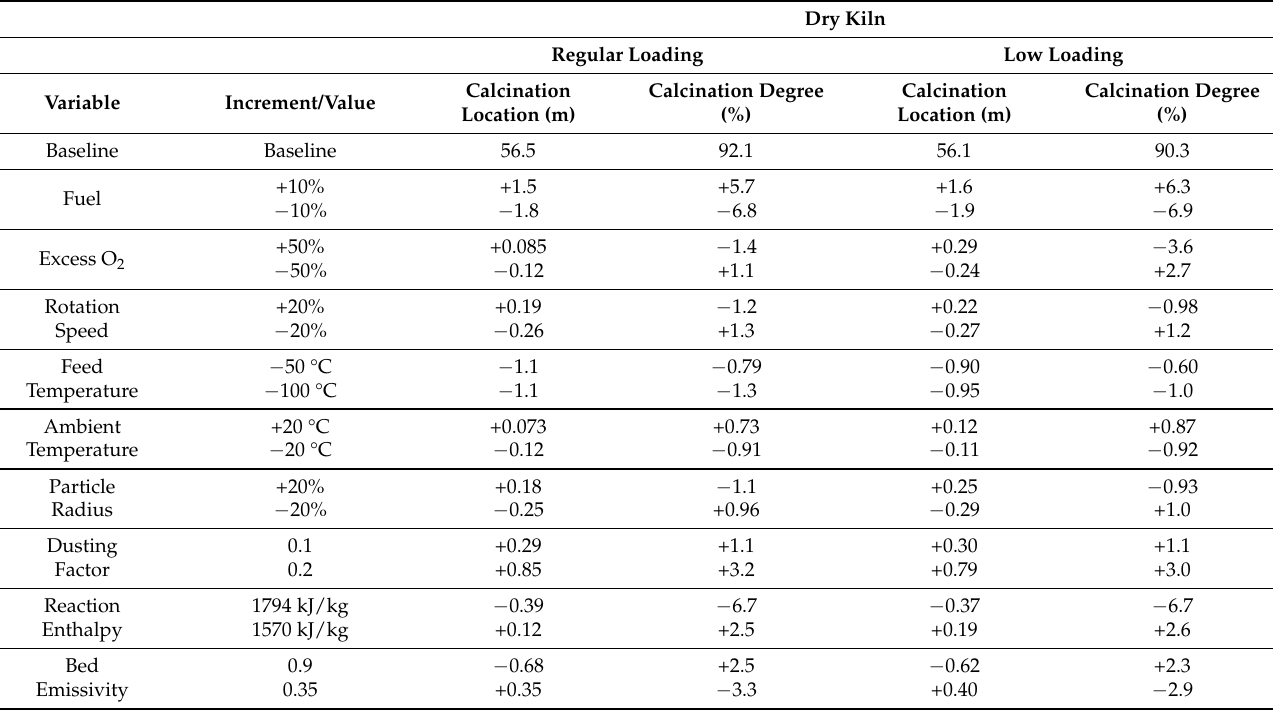
Table 6. Regular and low loading comparison for dry kiln.